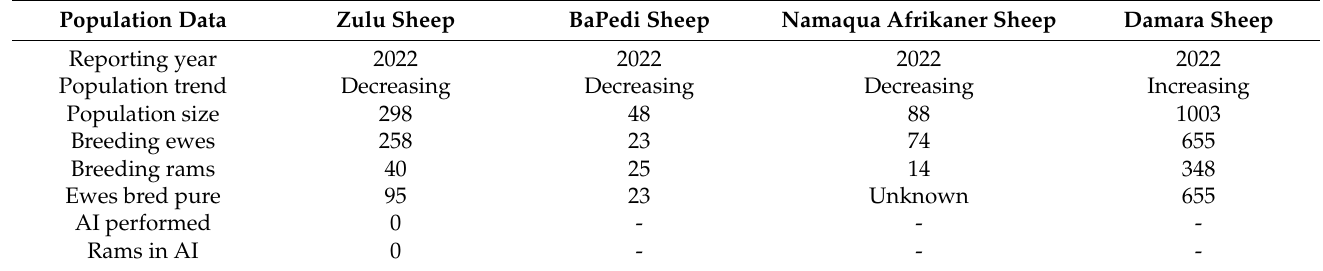
Table 2. Risk status of general South African indigenous sheep at a country level [16].